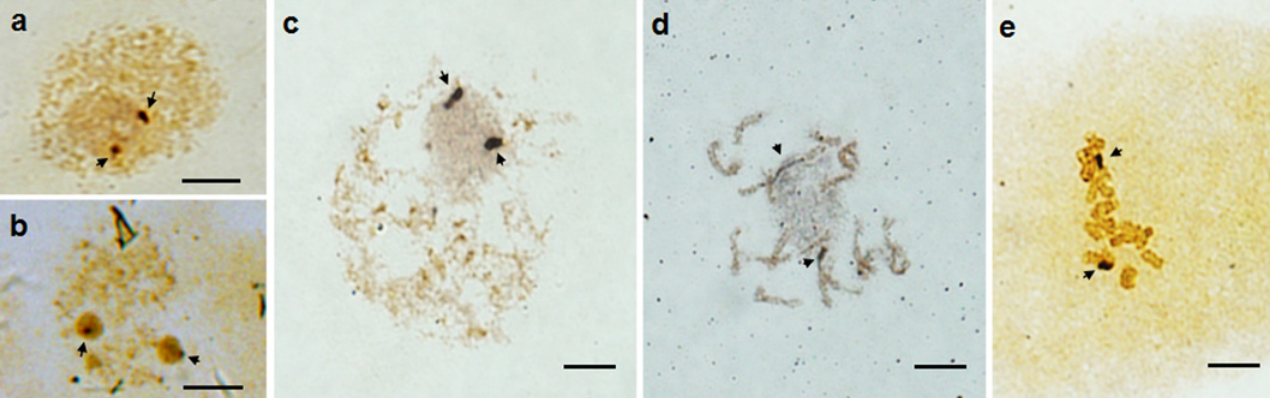
Fig 4. Silver staining of NORs in C . sinensis . a, interphase nuclei with one nucleolus; b, interphase nuclei with two nucleoli; c, prometaphase cell; d and e, metaphase chromosomes. Arrows indicate silver-stained NORs. Scale bars = 5 μ